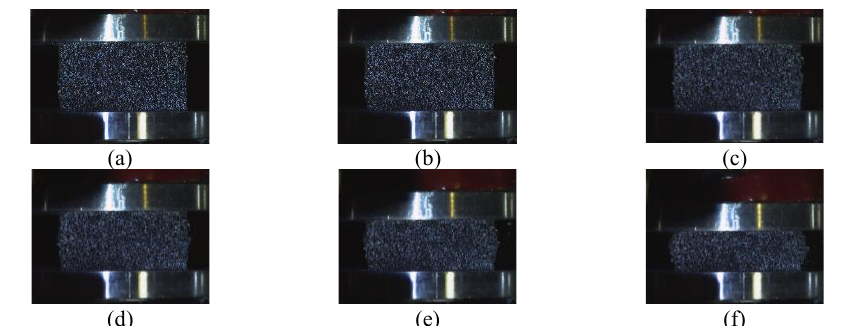
Fig. 4. Deformed test piece in dynamic test in the case of expansion ratio of 12; at engineering strain of (a) 0.04, (b) 0.08, (c) 0.12, (d) 0.19, (e) 0.32, (f) 0.44.